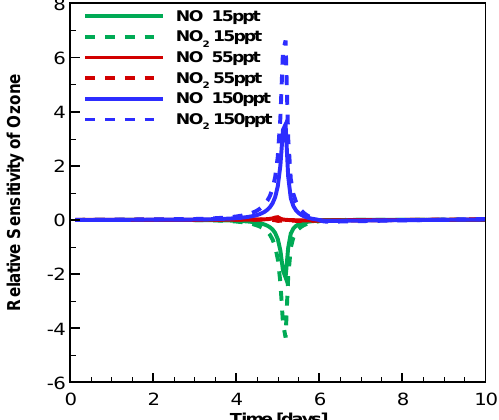
of 150ppt on day 4.5. x